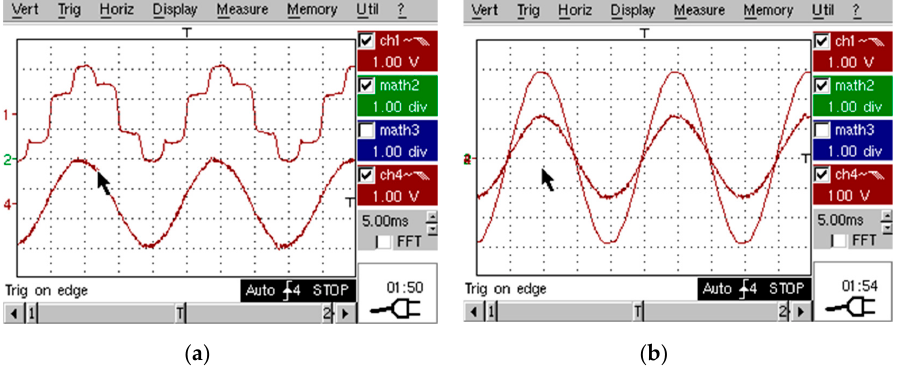
Figure 21. Oscillograms for the adaptive control at nominal load in steady state regime: ( a ) load current and supply current after compensation; ( b ) phase voltage and current after